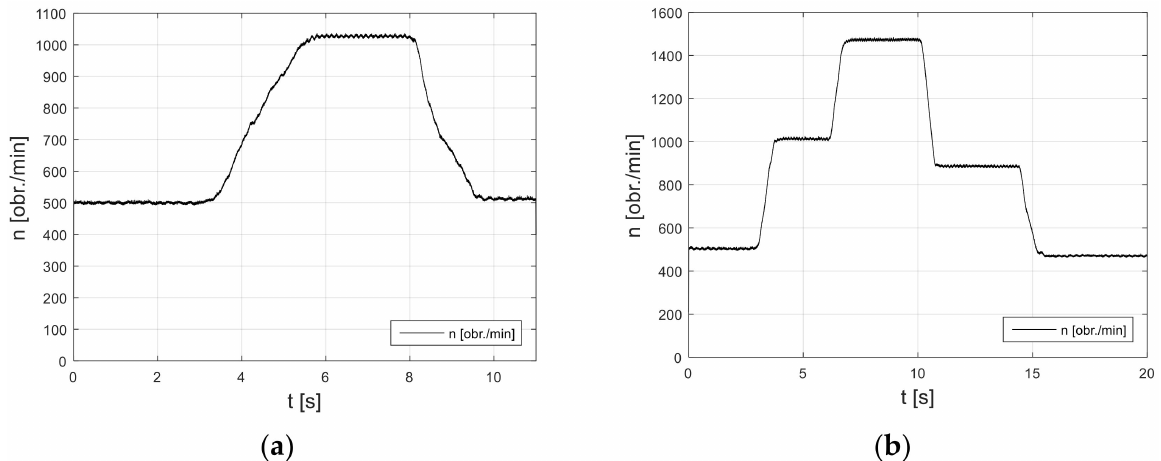
Figure 20. Waveforms of the forced rotational speed changes of the motor-pump assembly: ( a ) Single speed ramp; ( b ) Double speed